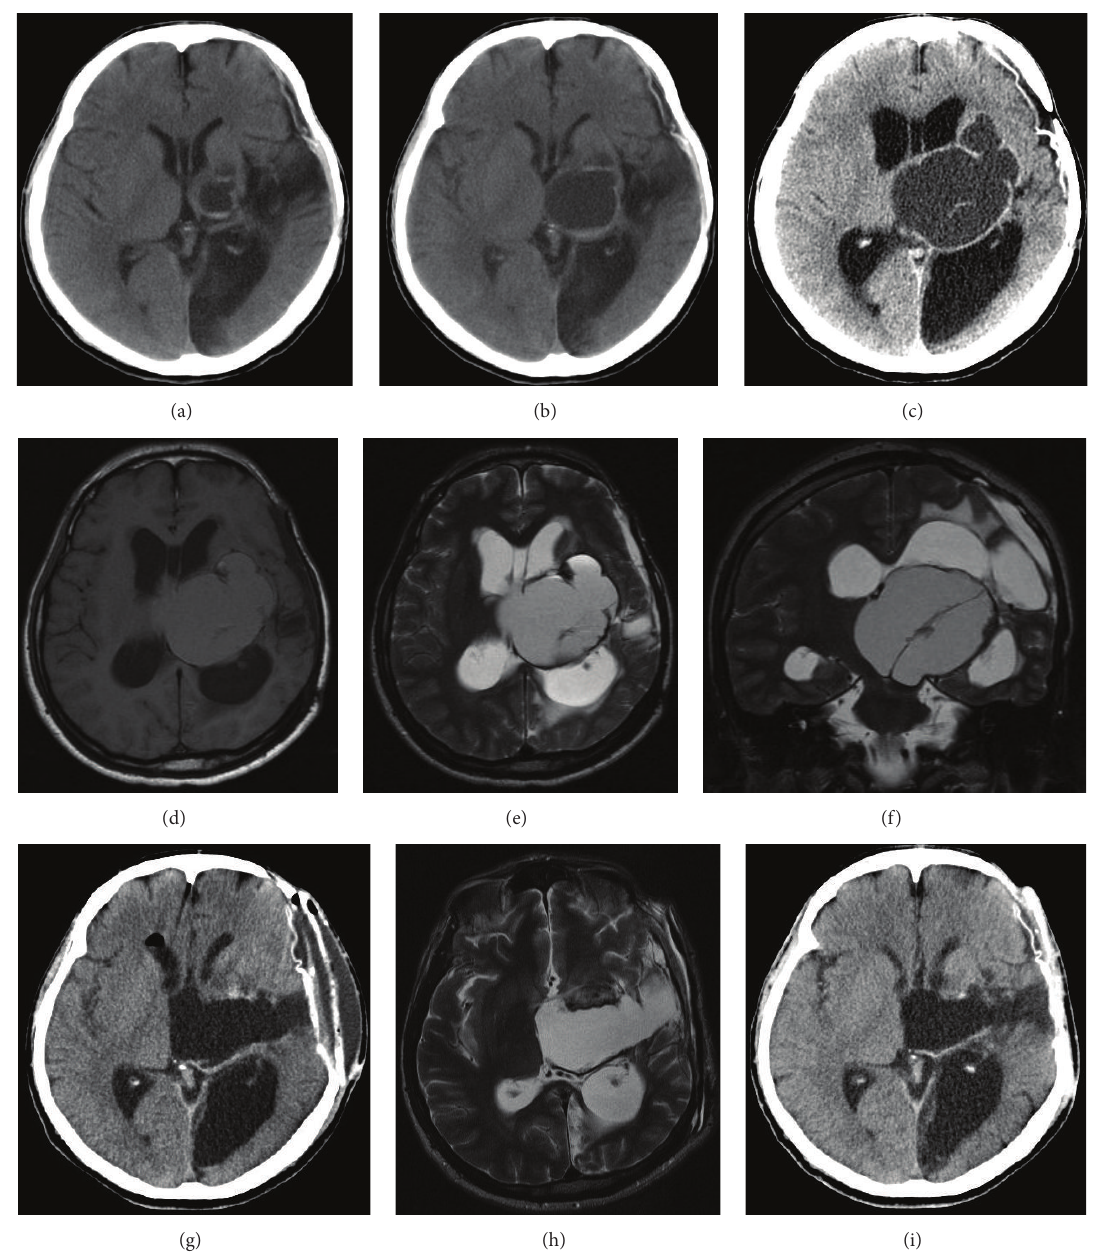
Figure 1: (a) Preoperative initial computed tomography (CT) 11 years after radiosurgery for an arteriovenous malformation in the left parietal lobe showing the cyst in the left thalamus. (b) Two years later, CT reveals that the size of the cyst is increased without hydrocephalus. (c) Four years later, CT reveals that the multilobular cyst is larger and accompanied by obstructive hydrocephalus. Preoperative magnetic resonance imaging (MRI)showing a cysticlesion in theleft thalamus appearing isointenseon T1-weighted imaging (d)and hyperintenseon T2-weighted axial (e) and coronal (f) imaging as well as association with obstructive hydrocephalus. Note thickened cyst wall and septum in the middle of the cyst. Postoperative CT (g) and MRI (h) show shrinkage of the hematoma cavity and improvement of hydrocephalus. CT scan one year after surgery demonstrates neither recurrence of the hematoma nor progressive hydrocephalus